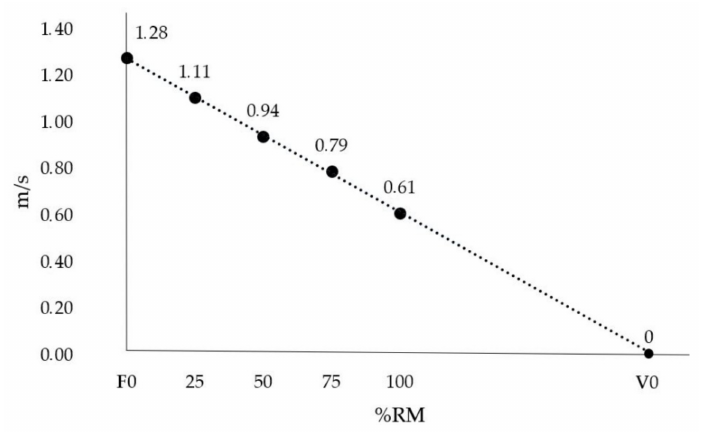
Figure 2. Shoulder internal rotation’s F-V